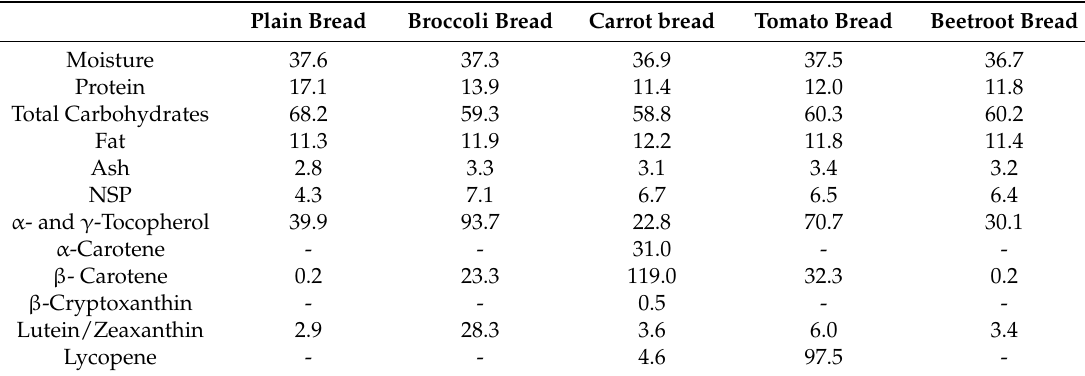
Table 1. Compositional information of the